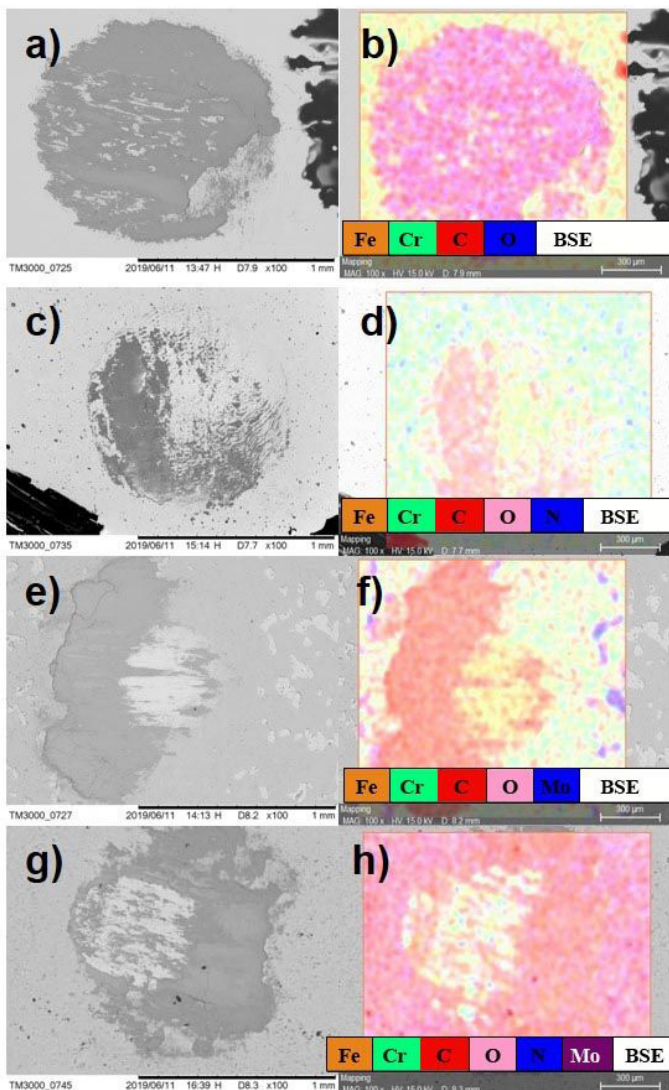
and (g-h) CPN400 + MoO x